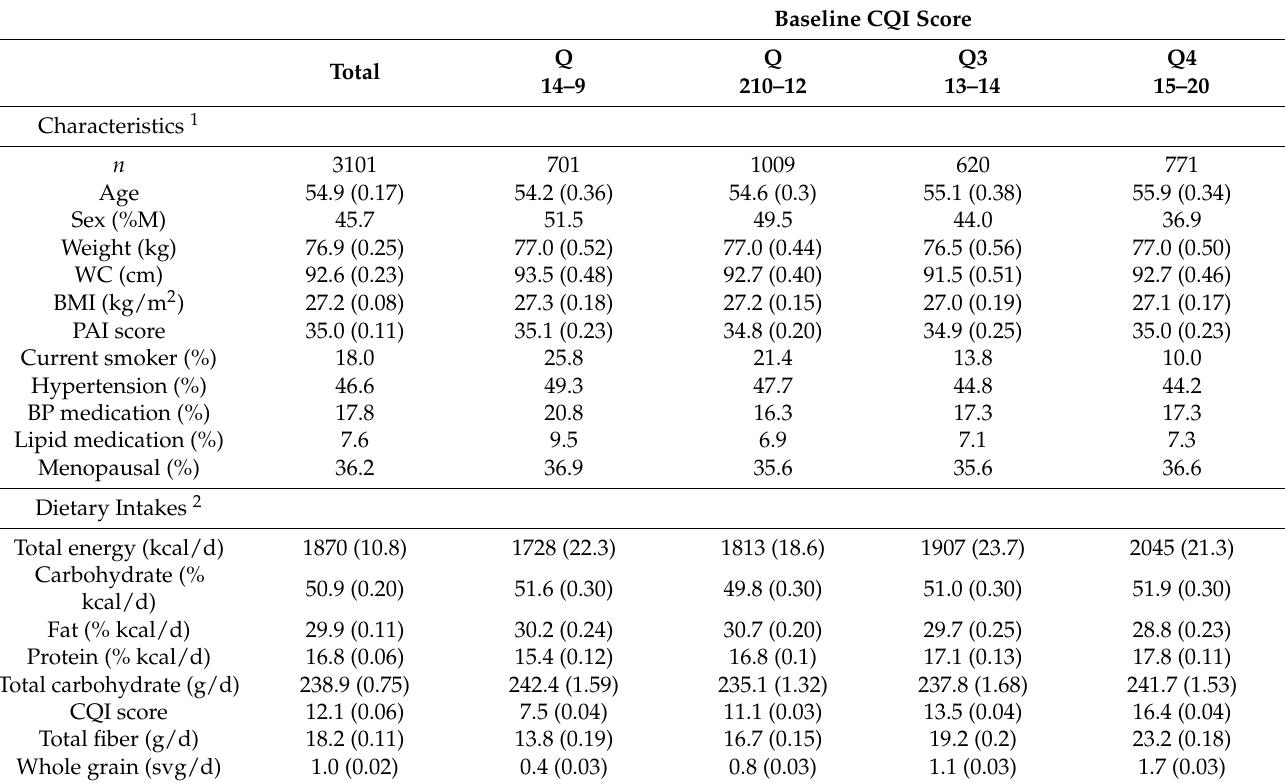
Table 2. Baseline characteristics across categories of CQI score among 3101 participants of the Framingham Cohort Study (mean (SE) or